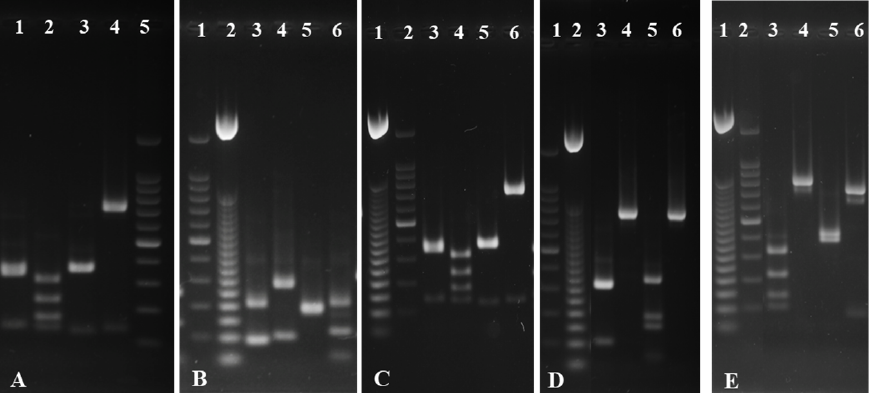
Figure 4. RFLP PCR profile of the ITS1-5.8SADNr-ITS2 region obtained for yeasts isolated from spontaneously fermented wine wort (( A ): MS1-1; ( B )-M3; ( C )-MD3; ( D )-M1; ( E )-M5). For each isolate, the restrictions were loaded in the following order: Cfo I; Hae III; Hinf I; Msp I; ( A )-5; ( B )-1; ( C )-2; ( D )-1; ( E )-2—100-bp DNA Ladder (ThermoFisher Scientific); ( B )-2; ( C )-1; ( D )-2; ( E )-1—BenchTop-50-bp-DNA Ladder (Promega). Table 3. Size of amplicons and restriction fragments obtained for the ITS1-5.8S-ITS2 region for yeasts isolated from wine wort and species of interest described in the literature (nd: not deter- mined).